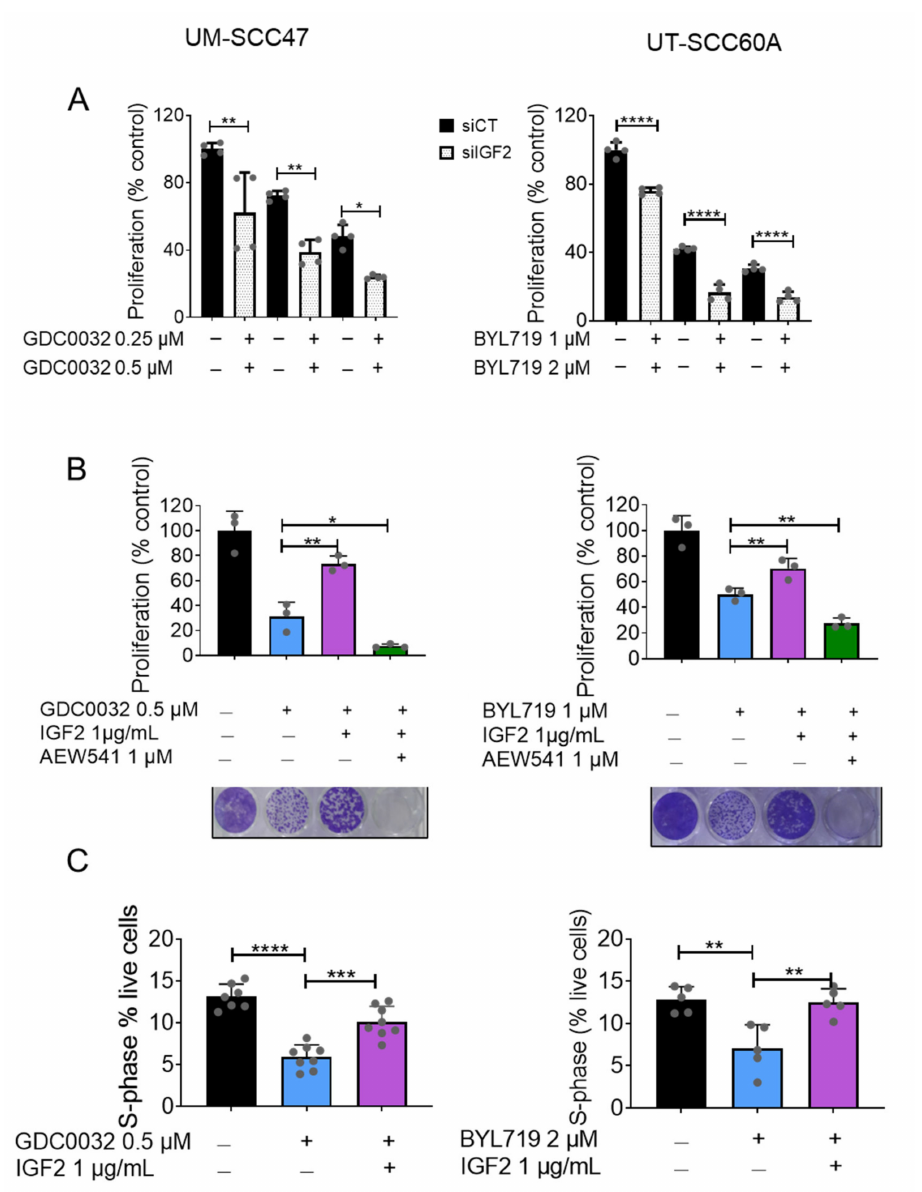
Figure 3. IGF2 limits the response of HNC HPV+ cells to isiPI3K. ( A ) UM-SCC47 and UT-SCC60A sensitive cells were transfected with either si-Control (siCT) or si-RNA targeting IGF2 (siIGF2) in the presence of DMSO, GDC0032, or BYL719. Cell viability was determined 4 days post-treatment using crystal violet staining. siRNA results of 2 independent experiments are presented as means ± SEM. Biological replicates from separate experiments are shown as grey dots. ( B ) UM-SCC47 and UT-SCC60A sensitive cells were cultured with DMSO, GDC0032, or BYL719, and AEW541, in the presence or absence of rIGF2. Cell viability was measured 4 days post-treatment using crystal violet staining. The proliferation experiment was repeated 3 times, and the results of a representative experiment are presented as means ± SEM. Biological replicates from one experiment are shown as grey dots. ( C ) UM- SCC47 and UT-SCC60A sensitive cells were cultured with DMSO, GDC0032 (500 nM), or BYL719 (2 µ M), with or without rIGF2. Three days post-treatment, cell cycle analysis was performed. The fraction of cells in the S-phase was determined. Cell cycle results of 2–3 separate experiments are presented as means ± SEM. Biological replicates from separate experiments are shown as grey dots. Statistical significance was calculated by one-way ANOVA, * p < 0.05; ** p < 0.01; *** p < 0.001; **** p <